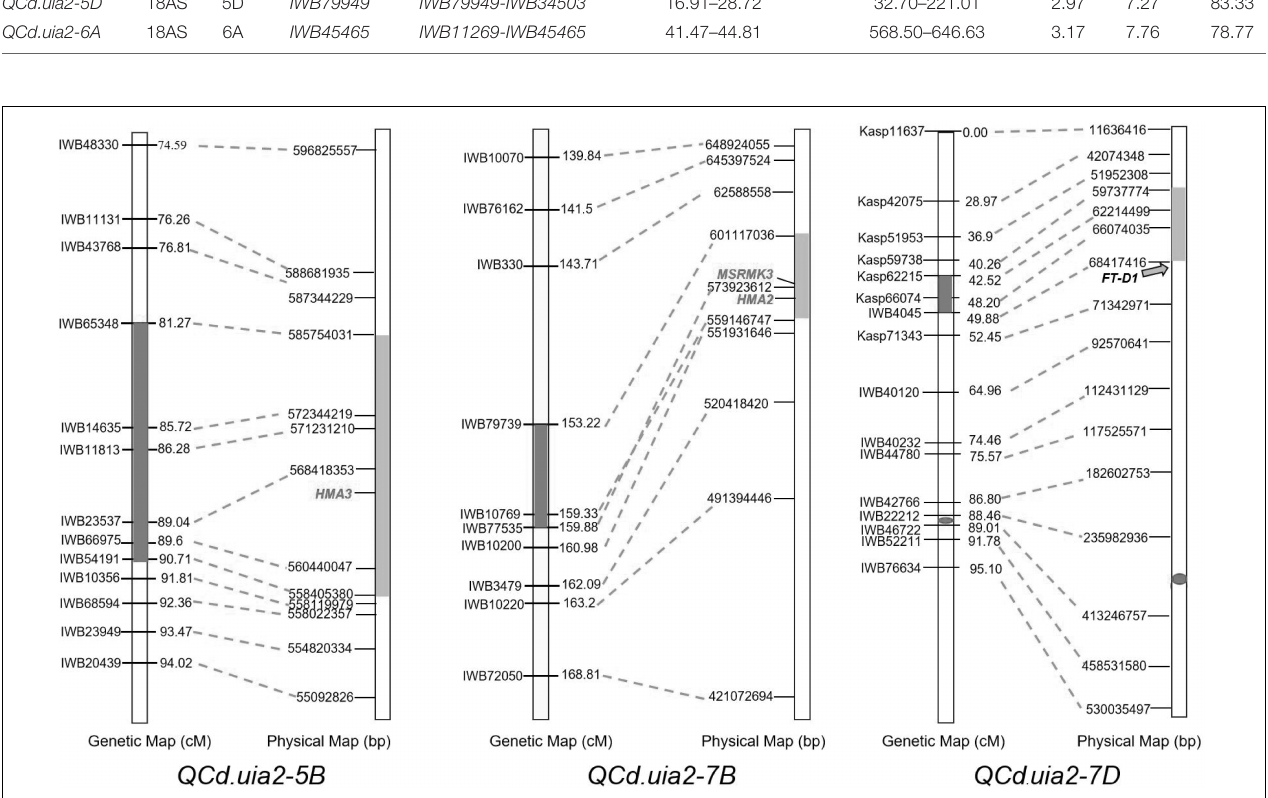
FIGURE 1 | Comparative genetic linkage and physical maps of QCd.uia2-5B , QCd.uia2-7B , and QCd.uia2-7D